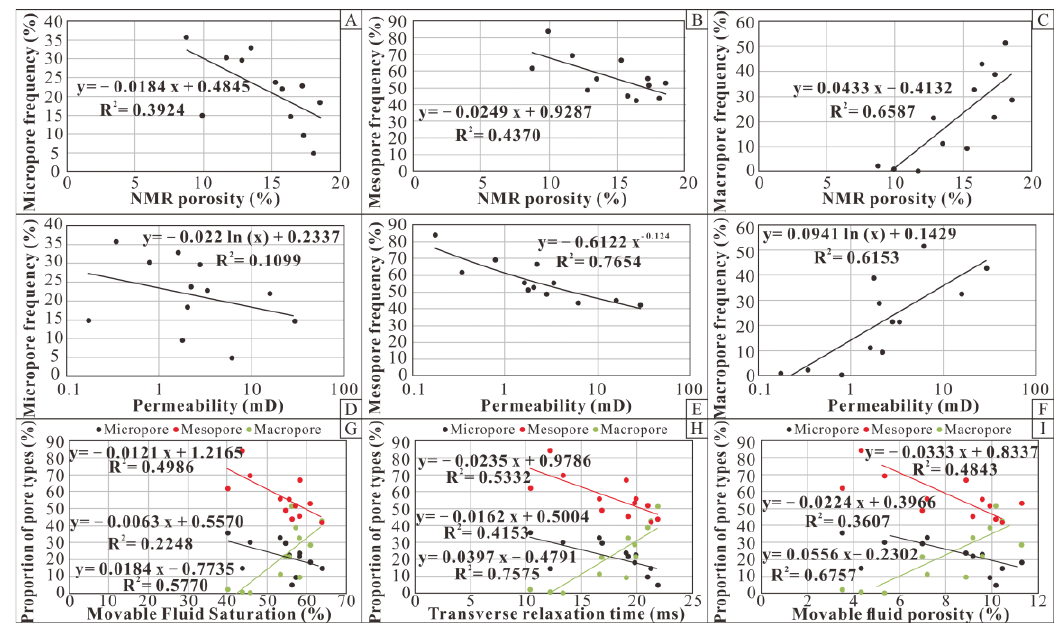
Figure 13. Correlation of macropore, mesopore, and micropore distributions with physical properties and NMR parameters. ( A ) Correlation between NMR porosity and micropore frequency. ( B ) Correlation between NMR porosity and mesopore frequency. ( C ) Correlation between NMR porosity and macropore frequency. ( D ) Correlation between permeability and micropore frequency. ( E ) Correlation between permeability and mesopore frequency. ( F ) Correlation between permeability and macropore frequency. ( G ) Correlation between movable fluid saturation and proportion of pore types. ( H ) Correlation between T 2 and proportion of pore types. ( I ) Correlation between movable fluid porosity and proportion of pore types.